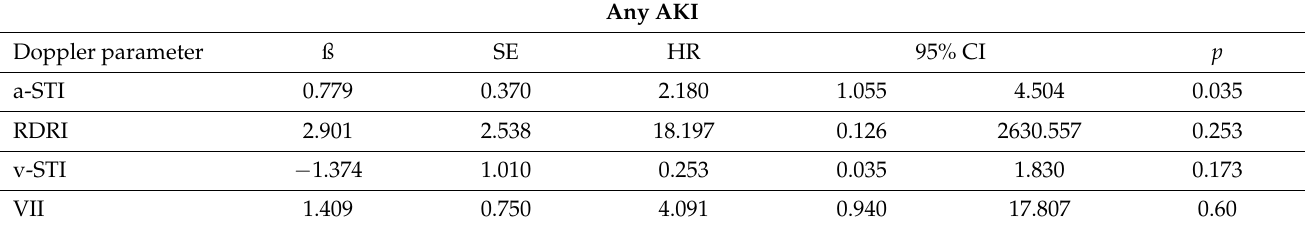
Figure 4. Panel ( A ): Comparison of the Kaplan-Meier curves for lack of adverse outcomes [any acute kidney injury (AKI)] in patients with a-STI equal or lower than 0.37 by using the log-rank test ( p < 0.001). Panel ( B ): Comparison of the Kaplan-Meier curves for lack of adverse outcomes (AKI-3) in patients with a-STI equal or lower than 0.63 by using the log-rank test ( p < 0.001). The number of patients at each time point is shown as a drop on the corresponding line. Patients were censored at day 5. Table 2. Univariate Cox proportional hazards model for the risk of any or severe acute kidney injury within the day 5 after ICU admission, by assuming as independent variables each Doppler parameter evaluated in this